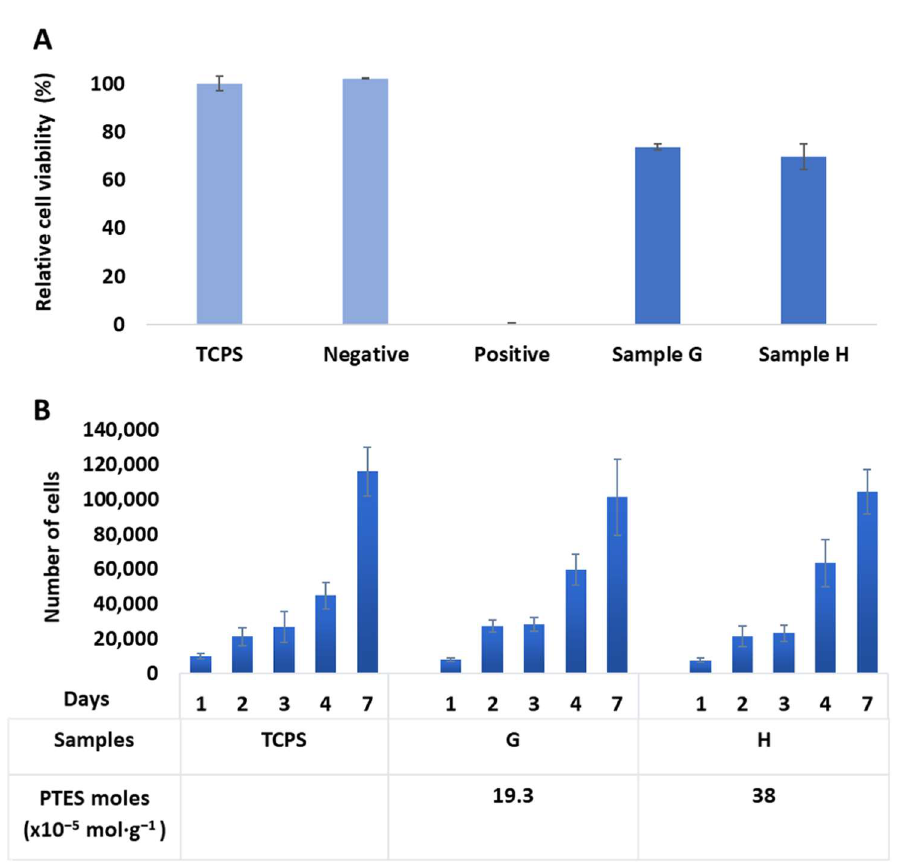
Figure 5. Biological evaluation in vitro: ( A ) Samples G and H were not cytotoxic after 24 h of contact with L929 cells compared to TCPS (tissue culture polystyrene); negative and positive controls were also tested (high density polyethylene film and polyurethane film + 0.1% zinc diethyldithiocarbamate, respectively). ( B ) The proliferation of L929 cells on G and H nanofibers was similar to that on TCPS over 7 days ( p > 0.05).